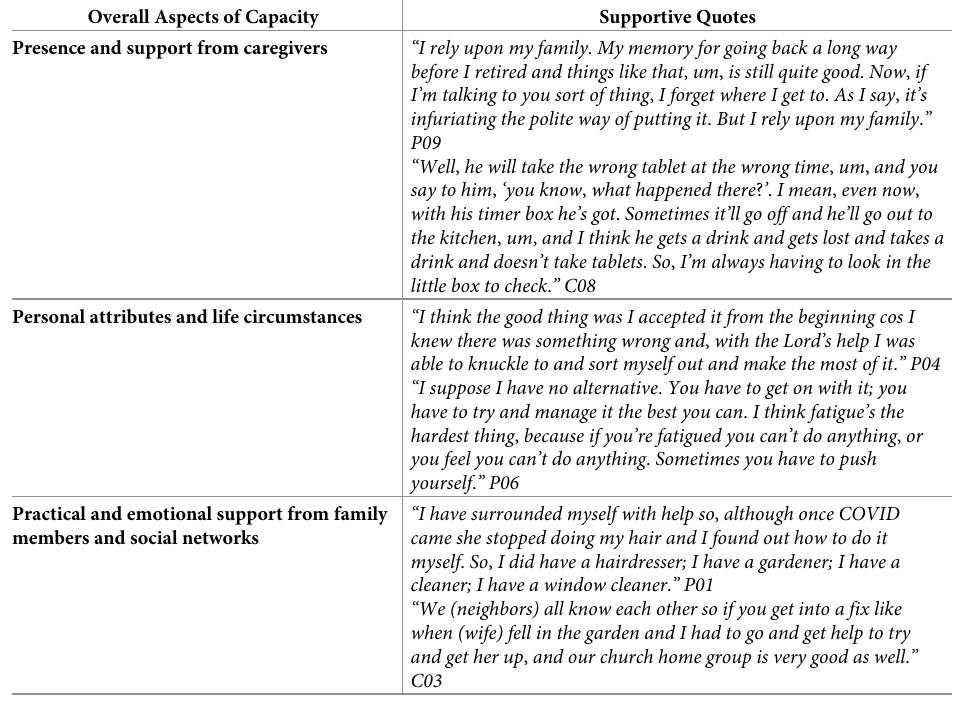
Table 3. Examples of participants’ quotes of overall aspects of capacity in Parkinson’s